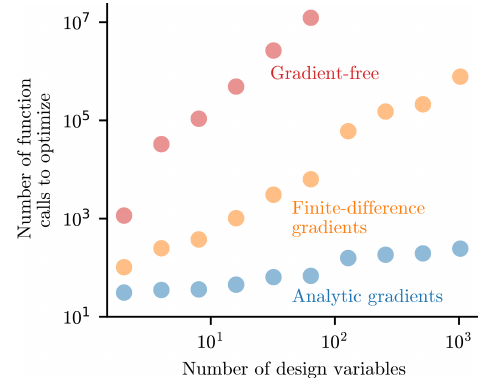
Figure 2. The number of function calls required to optimize the multi-dimensional Rosenbrock function versus the number of variables. The computational expense of gradient-free and finite- difference gradients scale poorly with the number of